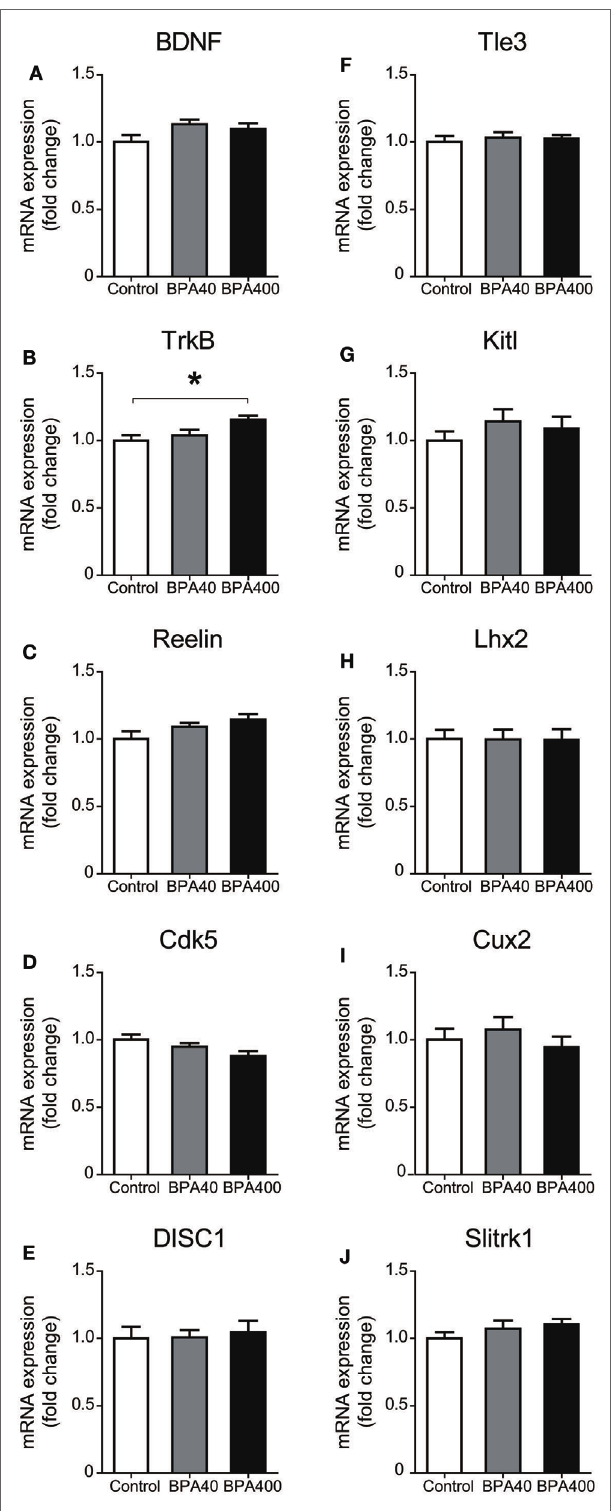
FigUre 2 | mrna expression of neuronal migration-related genes [BDnF (a), TrkB (B), reelin (c), cdk5 (D), and Disc1(e)] and cortical layer-specific genes [Tle3 (F), Kitl (g), lhx2 (h), cux2 (i), and slitrk1 (J)] in mouse forebrain. Data are shown as mean ± SEM, n = 6 per treatment, * p <